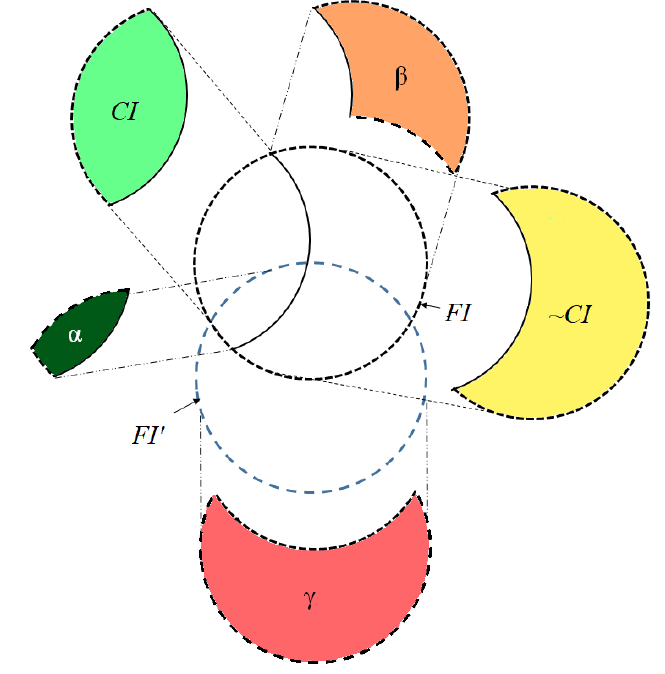
Figure 2. Three side effects of the sanitization